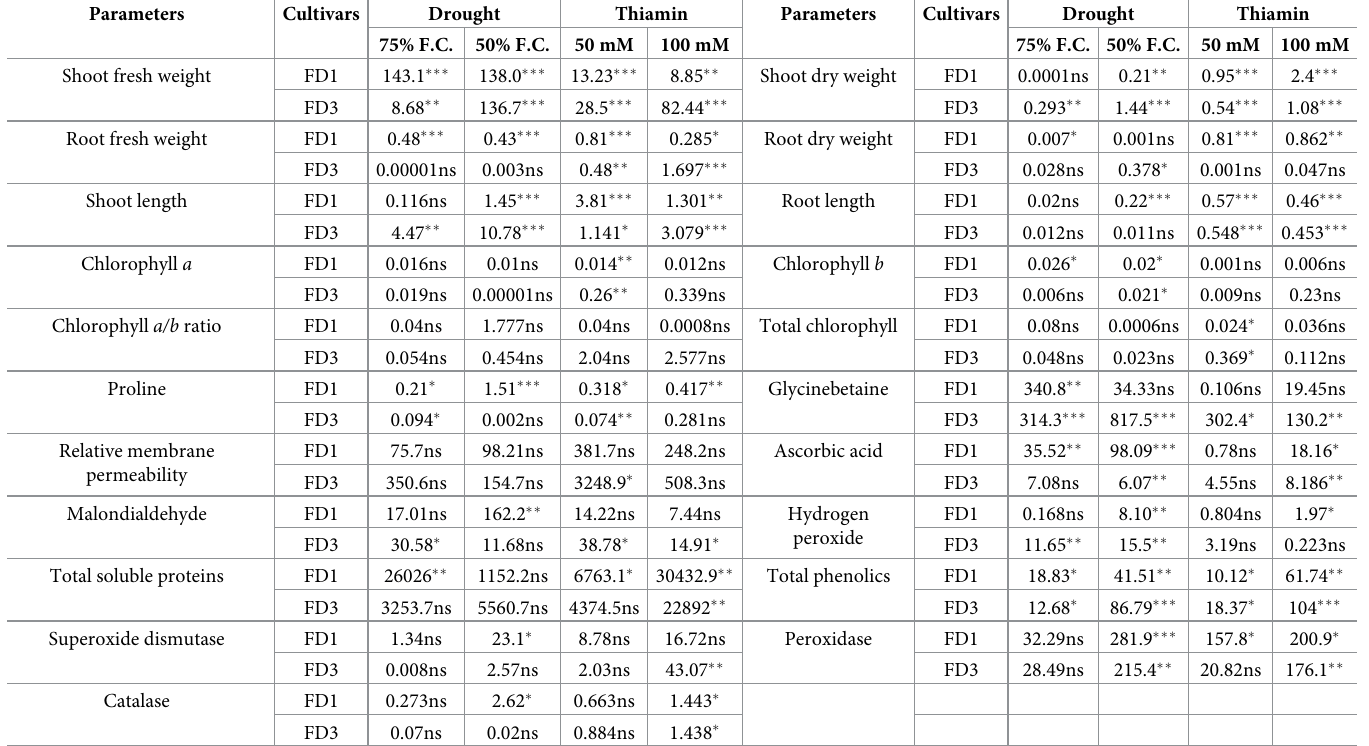
Table 2. Mean square values (post-hoc analysis) of different growth and biochemical attributes of cauliflower plants treated with thiamin under water deficit stress. Parameters